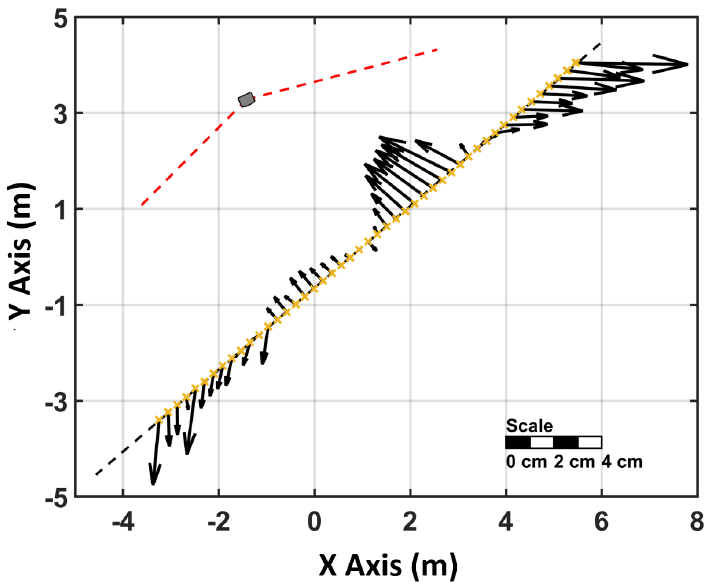
Figure 12. Horizontal deviations between the VR Tracker and the laser interferometer of the comparator.